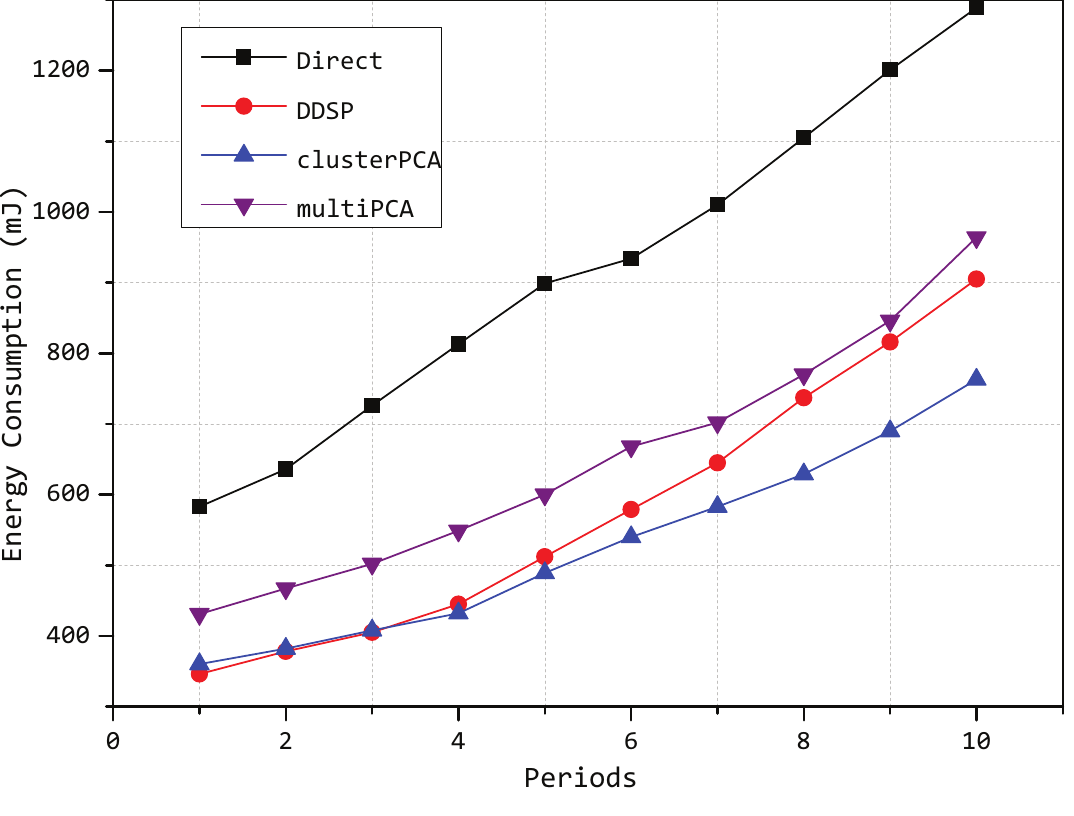
Figure 15. Energy consumption of each